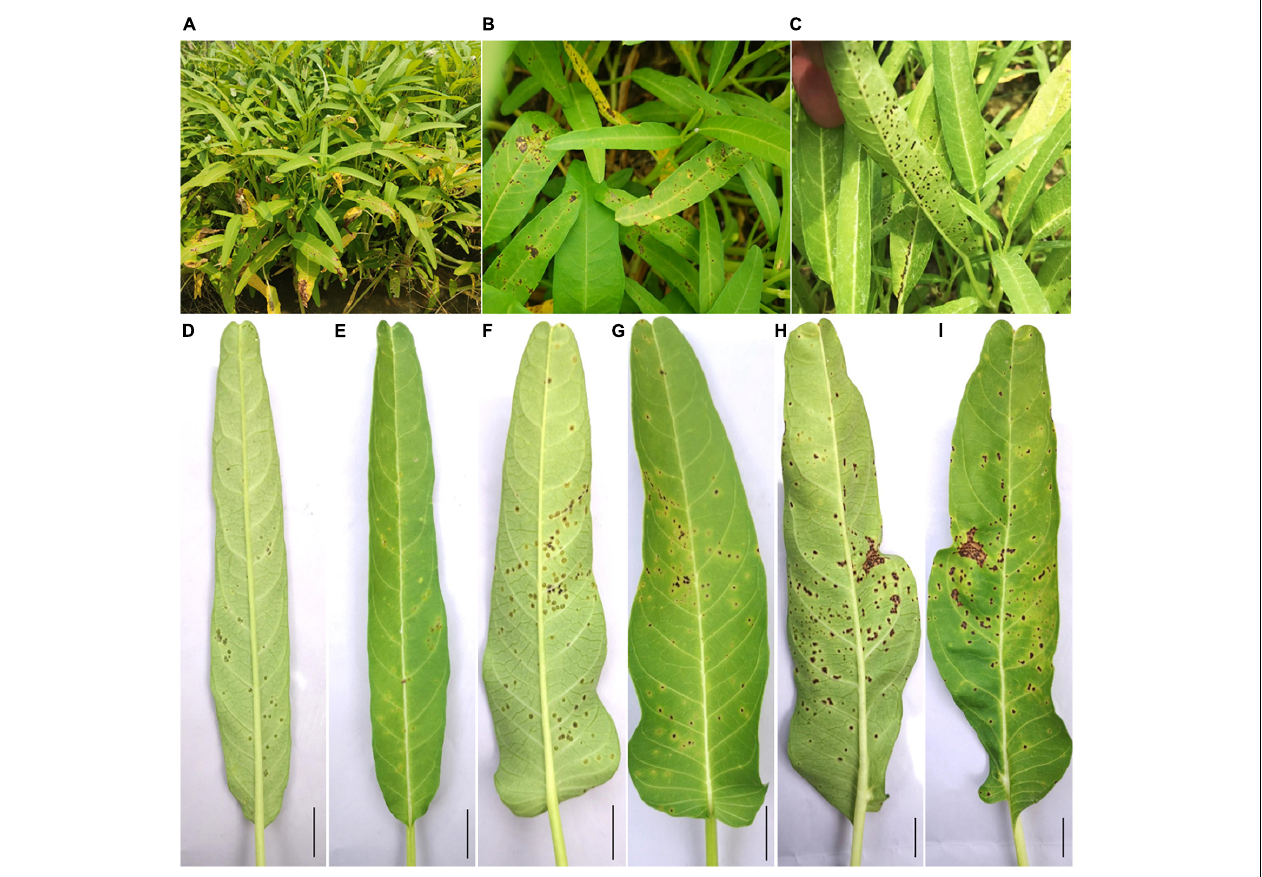
FIGURE 1 | Symptoms of bacterial leaf canker of water spinach in the field. (A–C) Diseased water spinach plants in the field. (D,E) Early symptoms on the lower and upper side of the leaf. (F,G) Leaf symptoms in the following course of disease development on the lower and upper side of leaf. (H,I) Leaf symptoms in the later stage on the lower and upper side of the leaf. Scale bar = 1